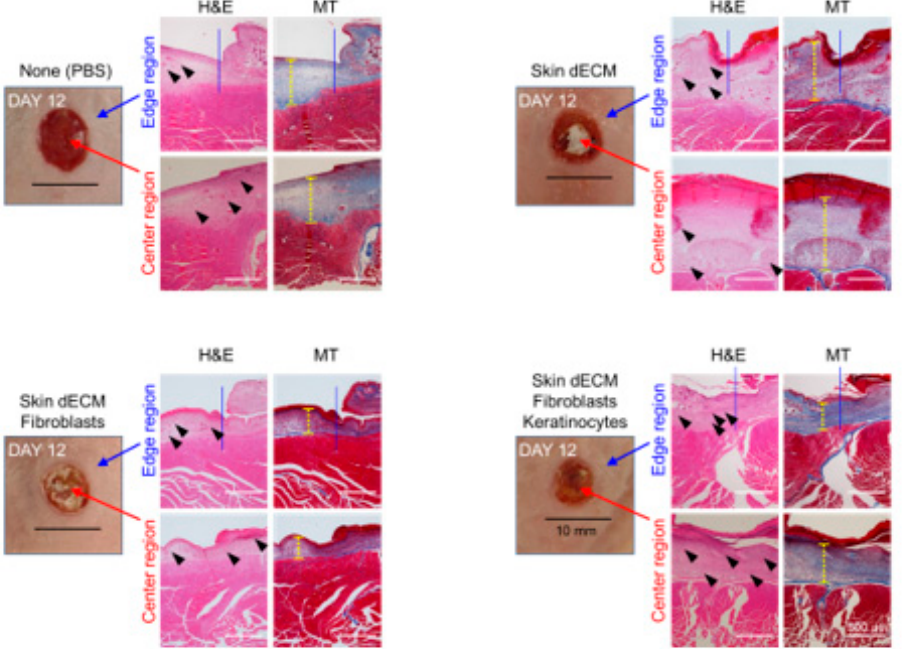
Figure 6. Histological analysis of cell infiltration and collagen deposition. Tissue samples stained with hematoxylin and eosin, and Masson’s trichrome stain, were analyzed at various stages on day 12. The images show stained tissue samples depicting the infiltration of cells into the dermal layer (black arrow heads) and fibrosis and collagen deposition at the site of damage (yellow line).